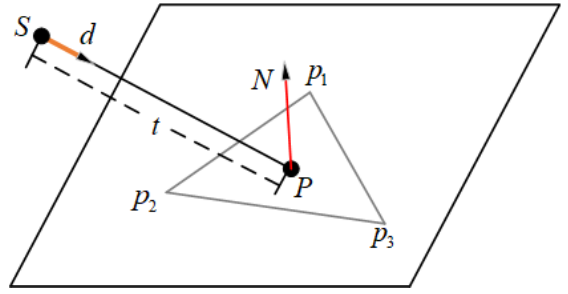
Figure 3. Collision analysis of electromagnetic waves and facets.